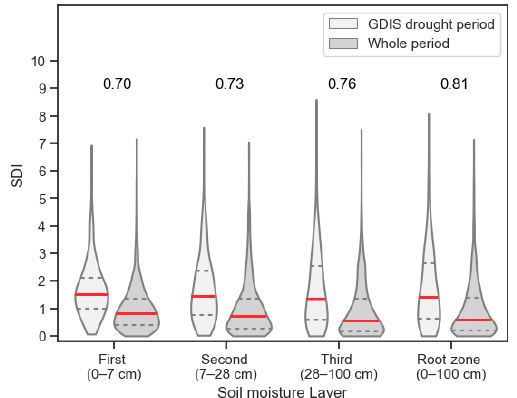
Figure 4. Comparison of SDI between the GDIS drought period and the whole period. The red line shows the median value, and grey dotted lines show the 25th and 75th percentile values of each distribution. The value above the violin plot shows the difference in the median values in the GDIS drought period and the whole period.